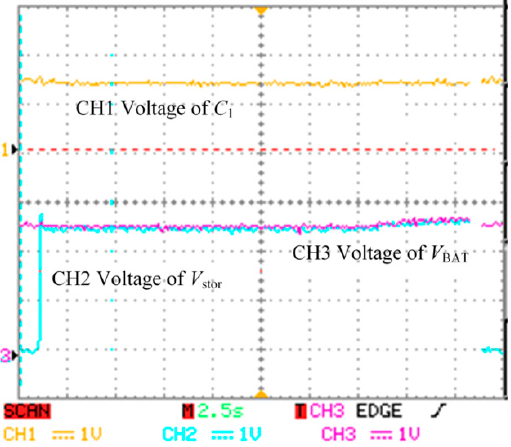
Figure 10. Start-up waveform of the proposed PMS.